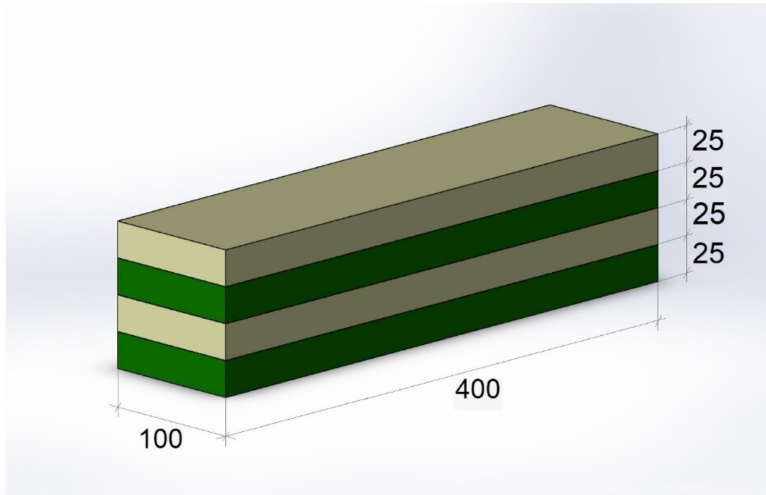
Figure 8. Fiber distribution in the prism of Group A5.